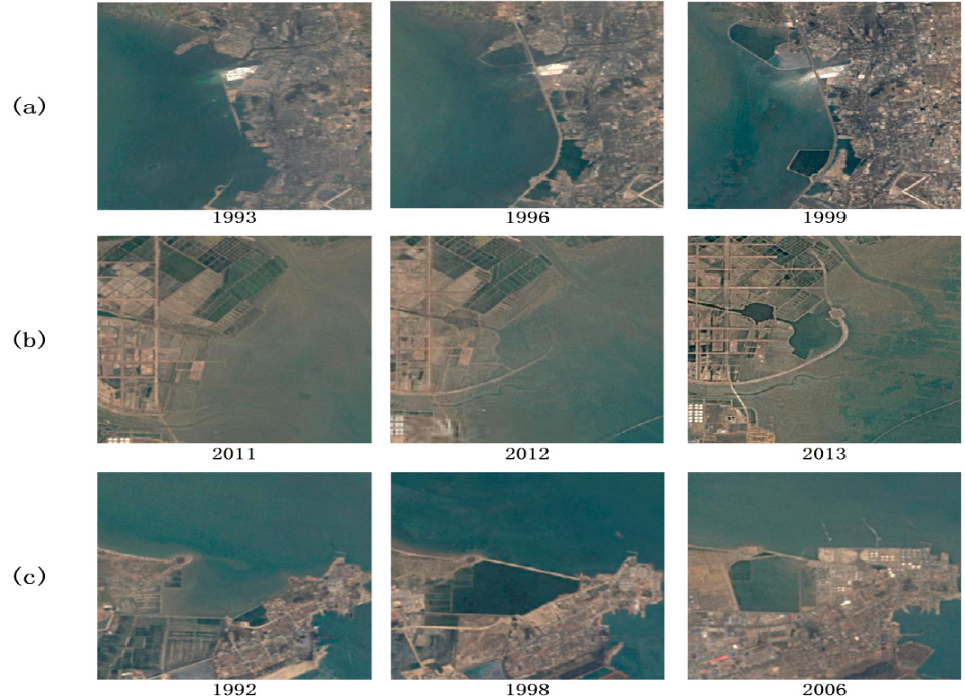
Figure 11. Schematic diagram of tidal flat changes in focus areas. ( a ) Along the shore of Banqiaofang; ( b ) on the northern bank of the Yanghe River; ( c ) along the northeastern coast of the community Xiaoshitou. The southwestern shore of Jiaozhou Bay, located in the area south of the Dagu River, is adjacent to the western coast of Huangdao and is another focus area for land reclamation in Qingdao (Figure 10a(ii)). In the past 30 years, Qingdao has made vigorous efforts to develop Huangdao District, and the original agricultural and fishery economy has been gradually replaced by sectors such as industry, commerce, and port-related